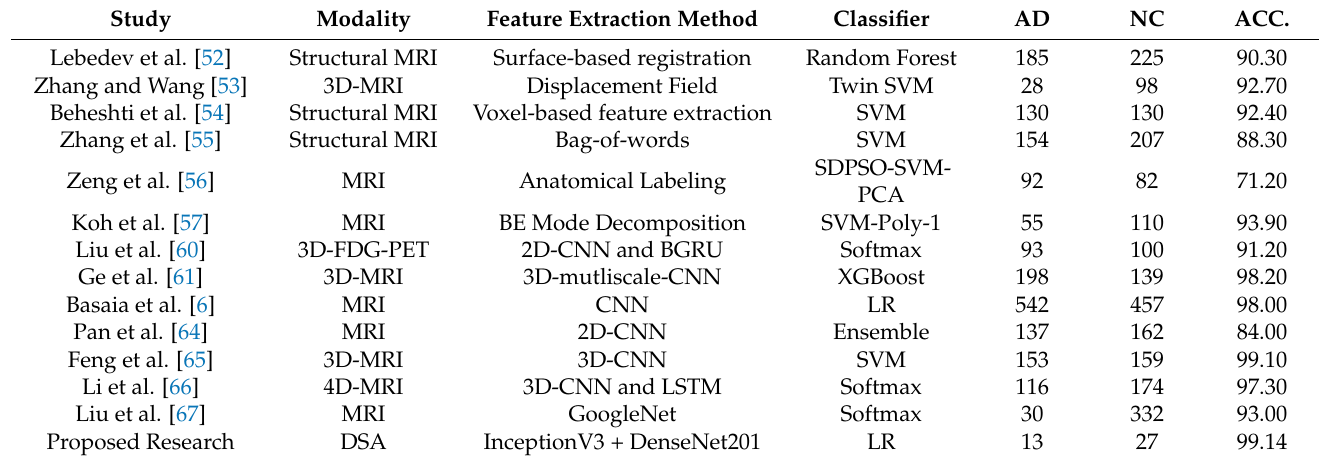
Table 6. Comparison between previous works and the proposed